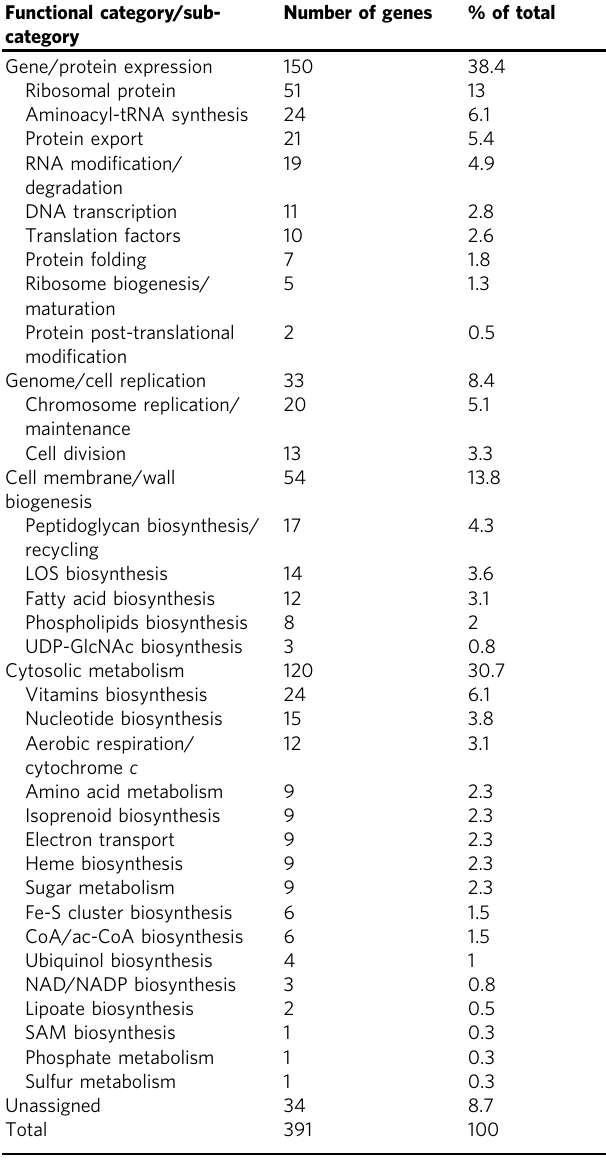
Table 1 Essential meningococcal genes listed by functional